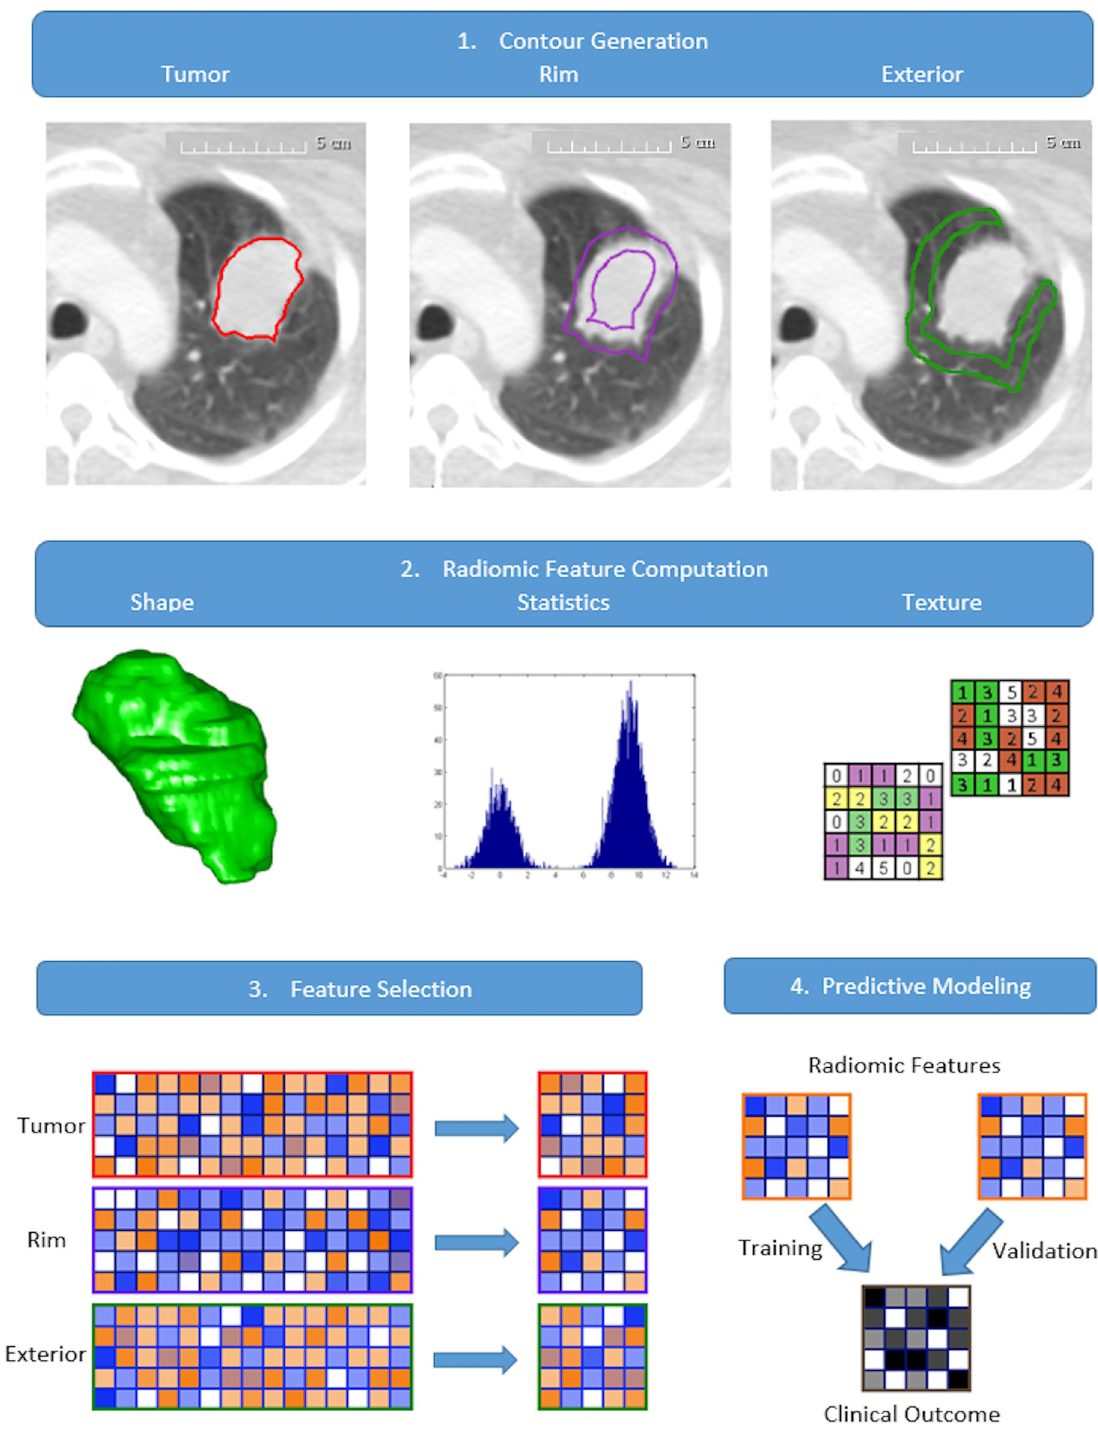
Fig 1. Schematic representation of the analysis workflow. 1. Generation of the rim and exterior contours based on segmented tumor contour. 2. Extraction of the radiomic features from each of the tissue contour region. 3. Dimension reduction of the radiomic features based on feature stability and relevance. 4. Prognostic power of the radiomic features is evaluated through predictive modeling and validation.